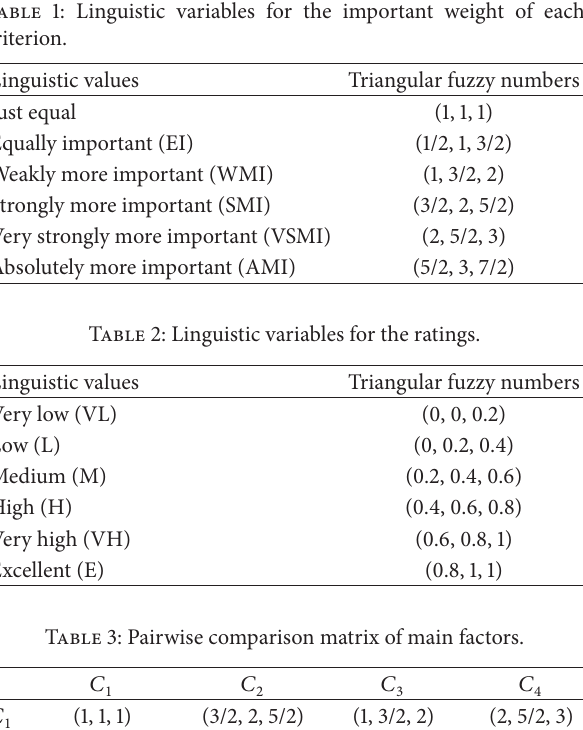
Table 4: Calculated global weights of the criteria with